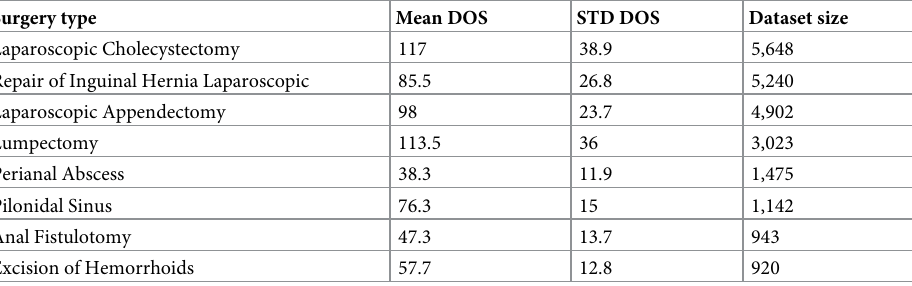
Table 2. Dataset statistics.